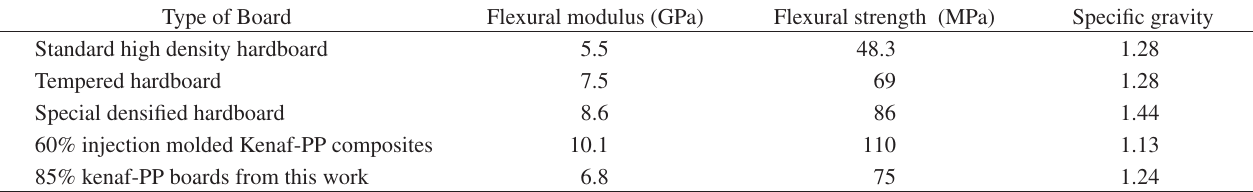
Table 3. comparison of flexural properties of commercial available hardboards (data from Wood Handbook) 40 with Data on 85% Kenaf-PP boards. Data on 60% kenaf-PP samples from Sanadi, et al. (1995).